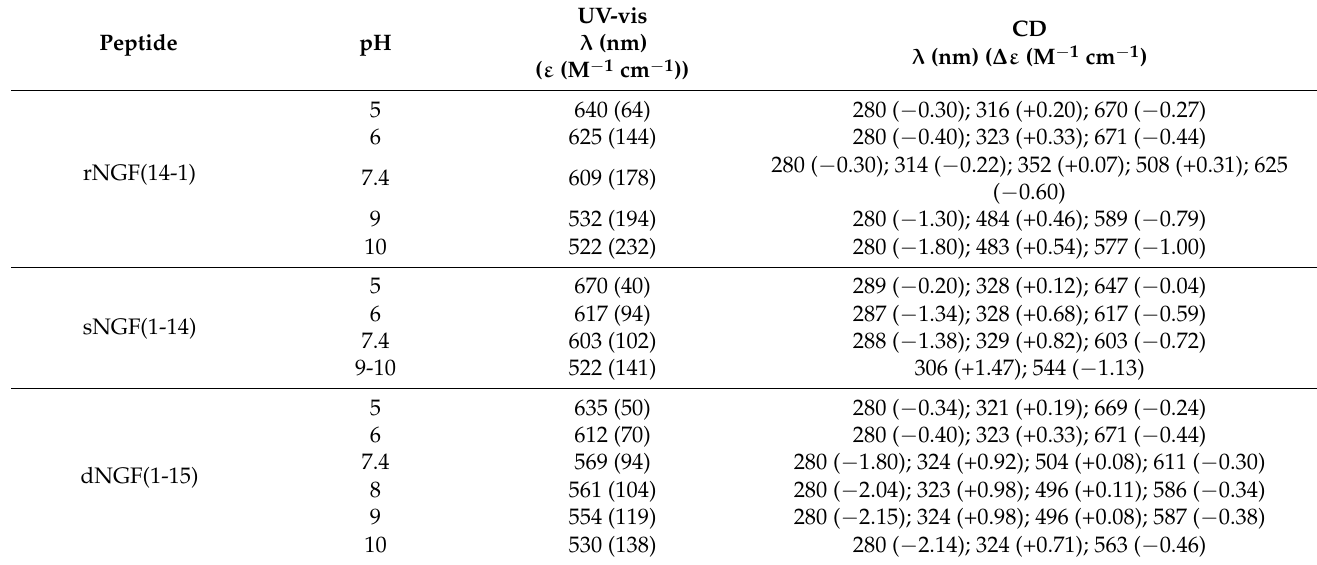
Table 3. Spectroscopic parameters of Copper (II)